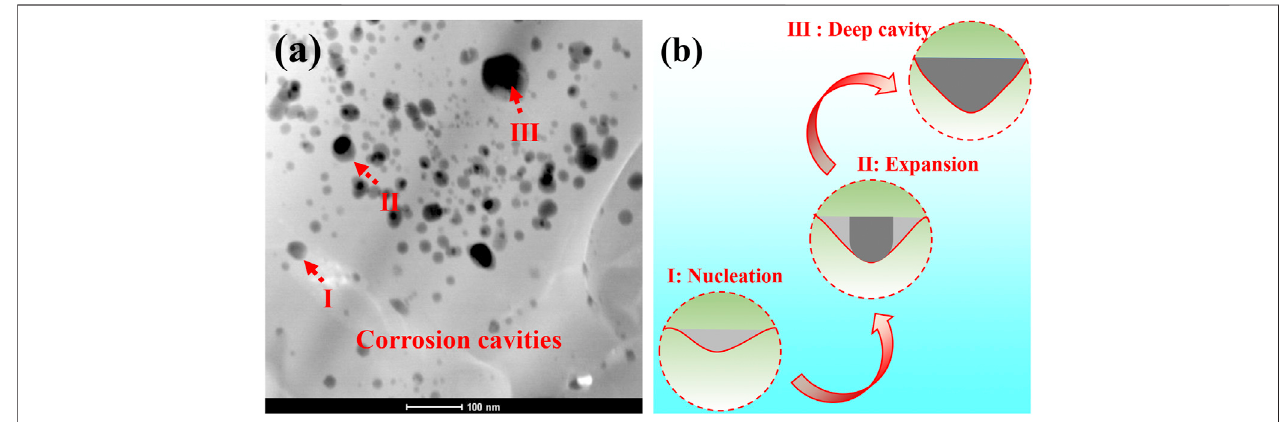
FIGURE 10 | (A) Cross-sectional TEM morphology of oxide scale formed on the as-received aluminide coating after hot corrosion for 120 h in Na 2 SO 4 salt at 1050 ° C; (B) the schematic diagram of corrosion cavity morphology.